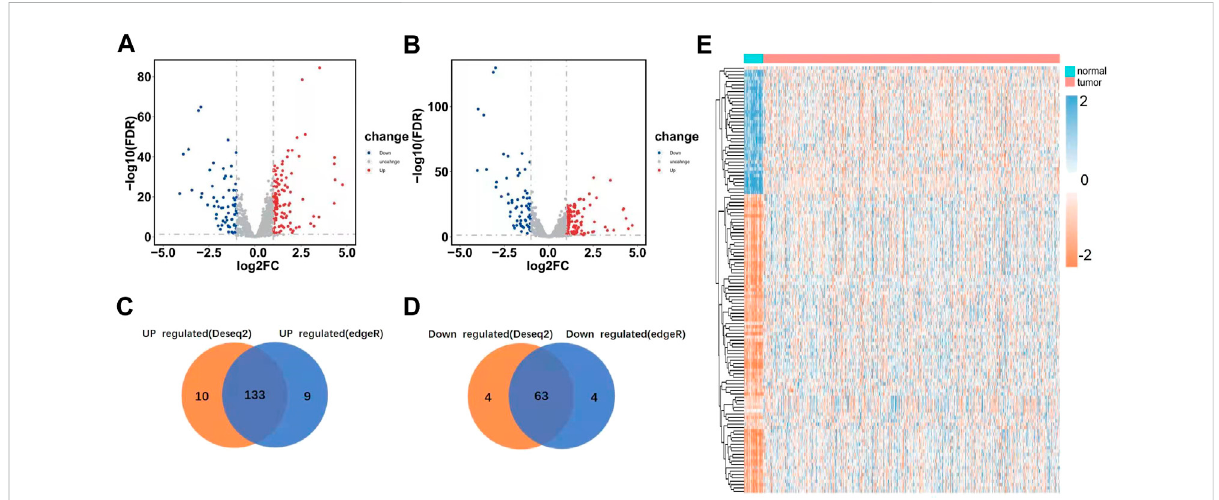
FIGURE 2 Differently expressed RBPs in UCEC. (A) Differently expressed RBPs as screened out by DESeq2 and meet the criteria of |log2FC| > 1, FDR < 0.05. (B) Differently expressed RBP as screened out by edgeR and meet the criteria of |log2FC| > 1, FDR < 0.05. (C – D) Venn plots of differently expressed RBP were screened by DESeq2 and edgeR. (E) Heatmaps of the differently expressed